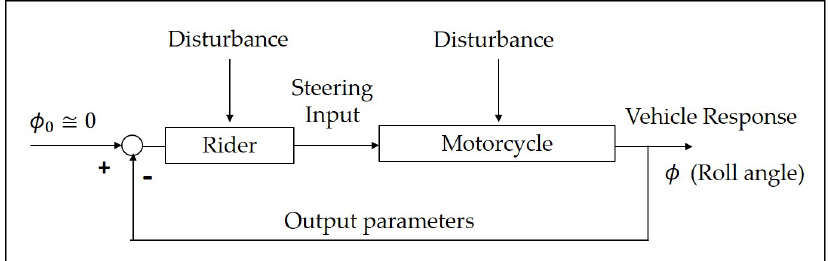
Figure 1. Block diagram for the low-speed stability of a motorcycle and rider